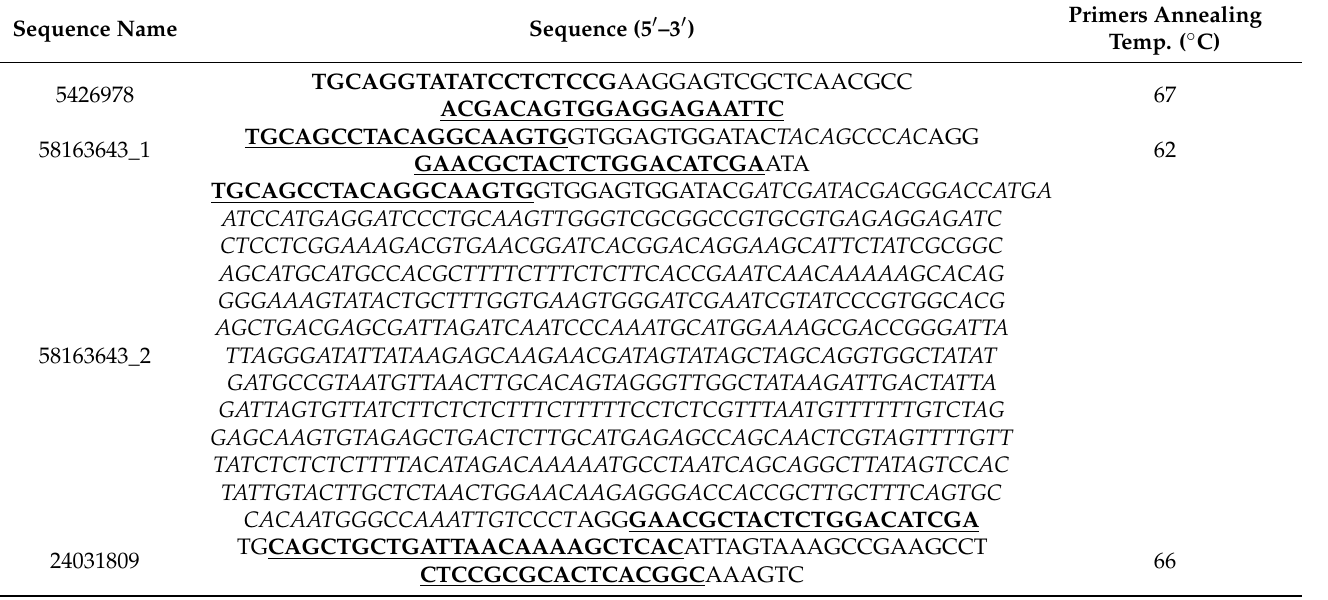
The bold, underlined regions are the sequences used for SCAR primer design. The italics mark sequences differing resistant and susceptible alleles of